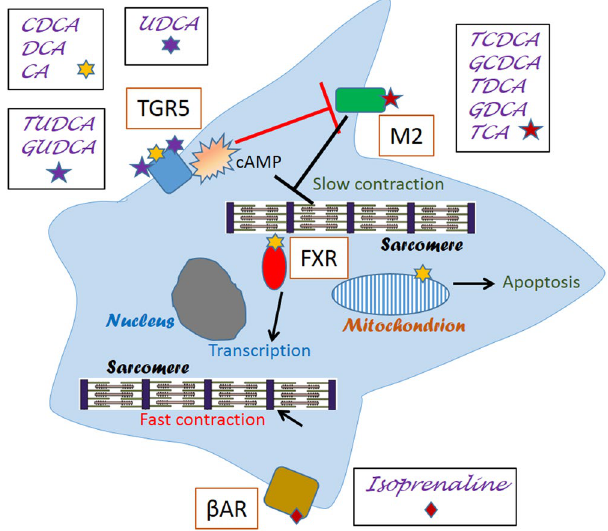
Figure 8. Schematic representation of signalling by various bile acids in